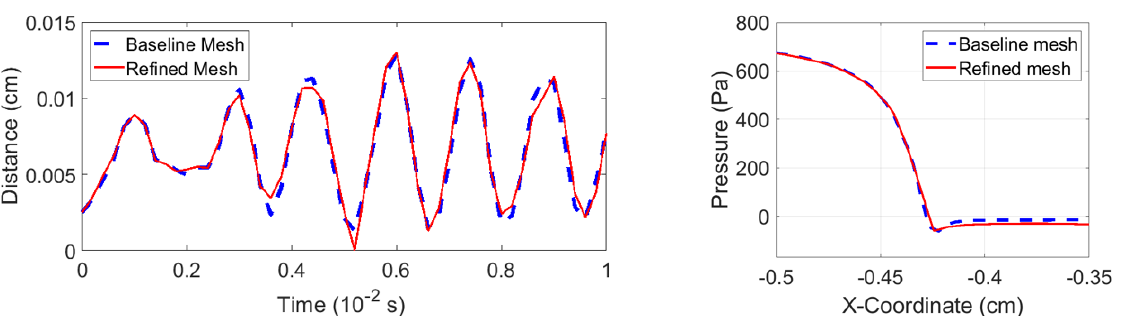
Figure A2. Left : vocal fold displacement; right : intraglottal pressure plot at t = 0.6 cs for the baseline and refined meshes (Sample